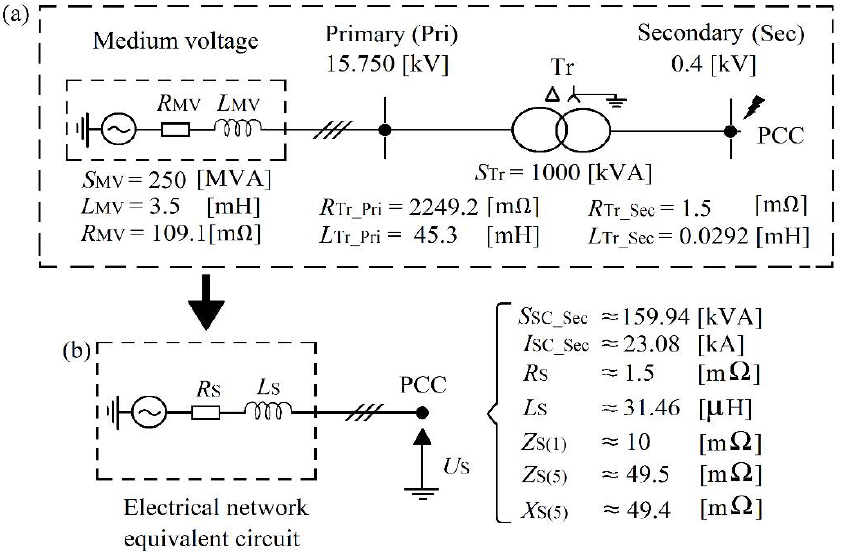
Figure 2. ( a ) Parameters of the electrical grid supplying the laboratory setup, ( b ) electrical grid equivalent circuit. Sec–Secondary, Pri–primary.